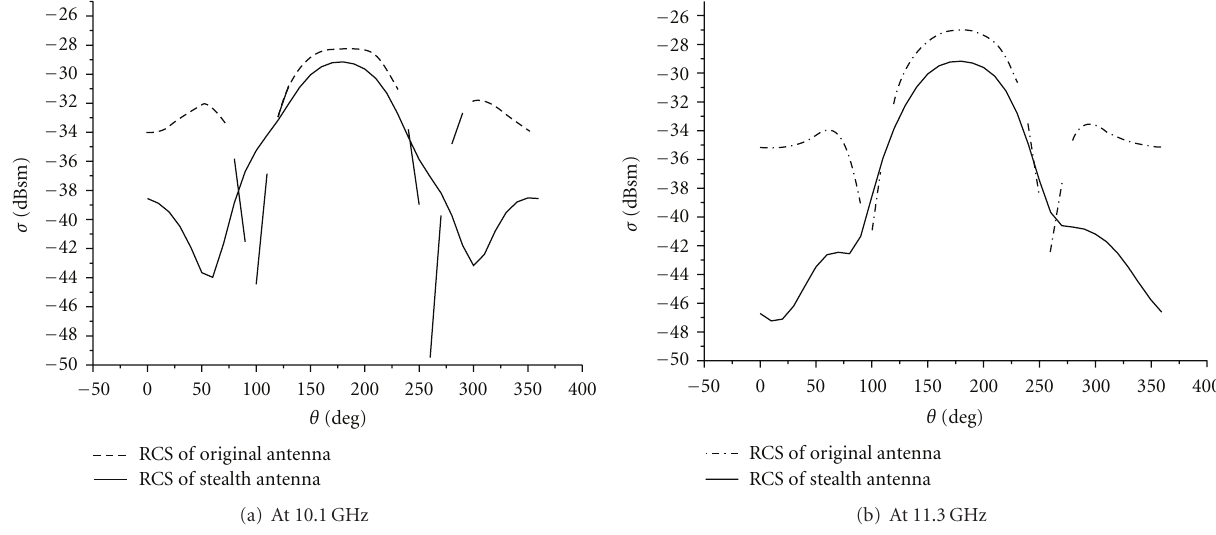
Figure 8: RCS with the change of